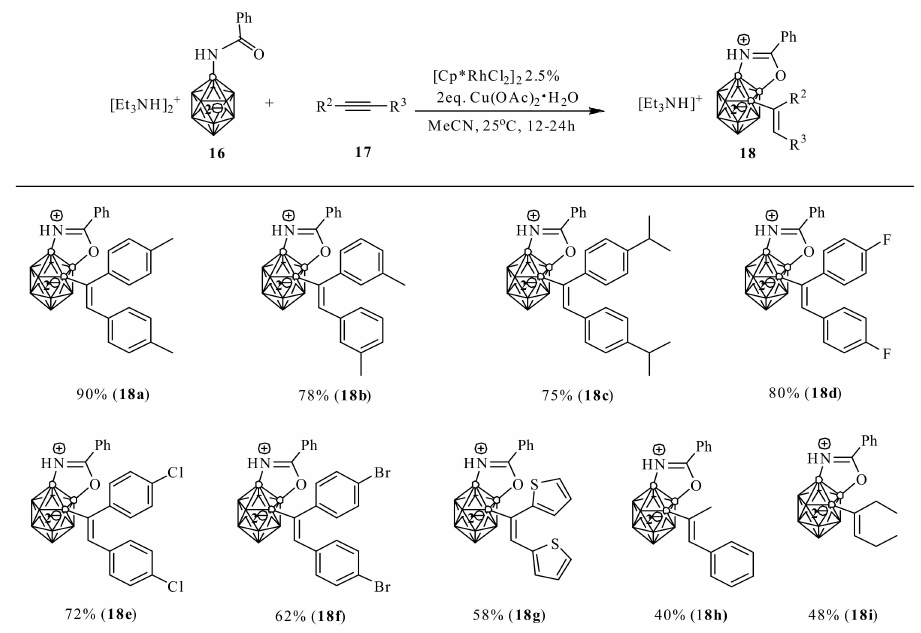
Figure 6. Synthesis of dodecaborate-fused oxazoles with amide as directing